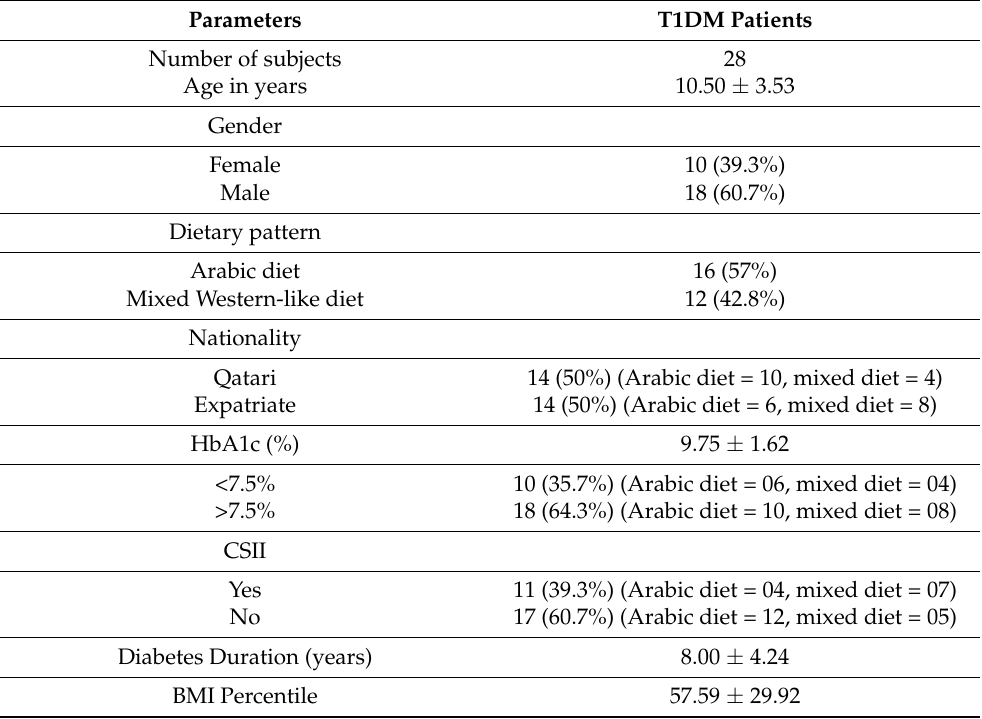
Table 1. General characteristics of the study